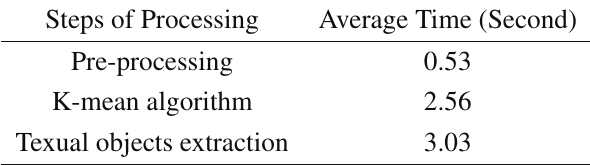
Table 2: The processing time for text